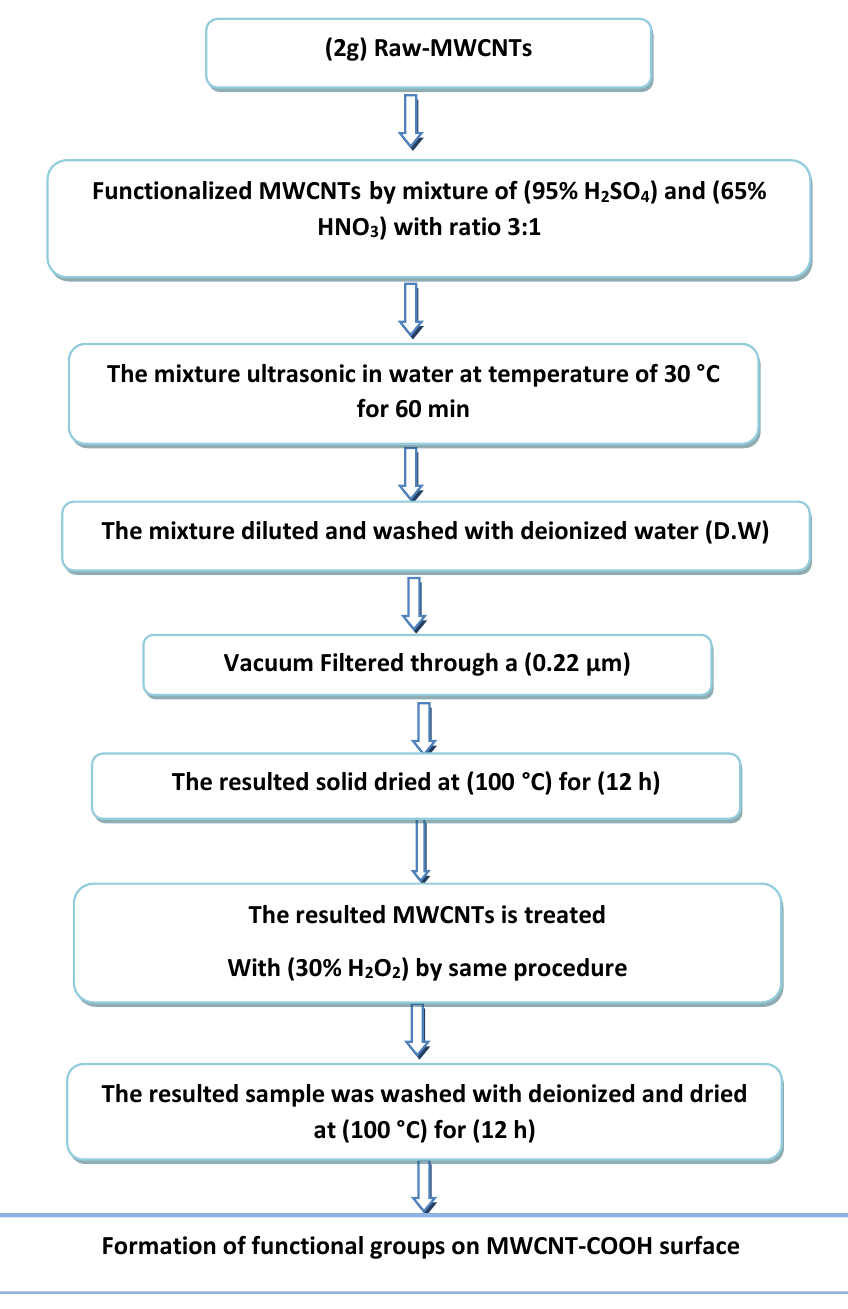
Figure 1: Schematic diagram of represents functionalized method by using concentrated mixture of sulfuric acid and